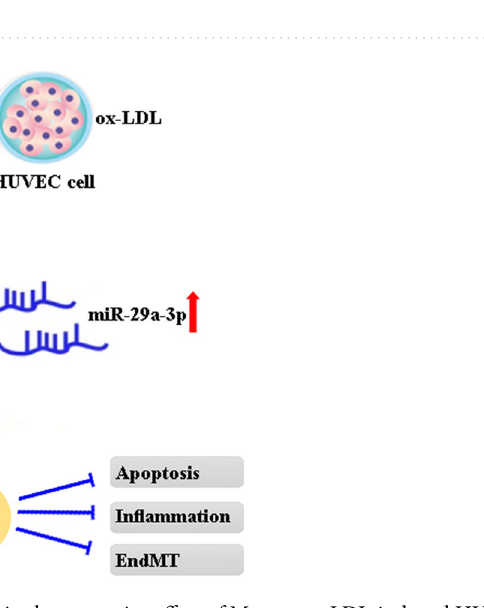
Figure 8. Scheme of the mechanisms in the protective effect of Myr on ox-LDL-induced